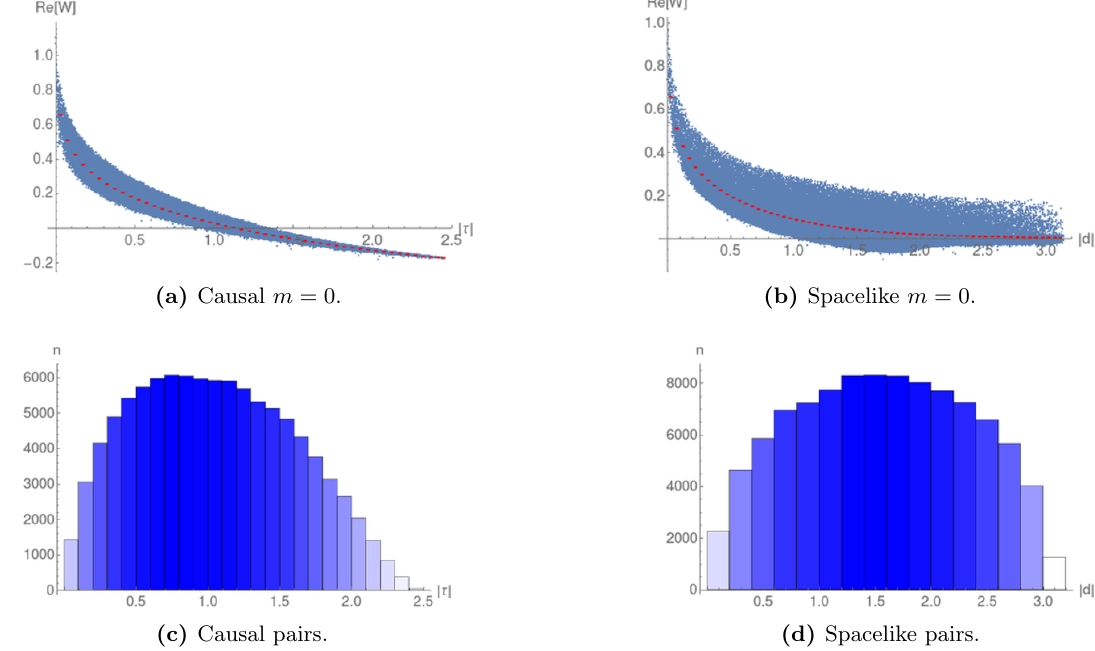
Figure 11. N = 32000 ; T = 1 ; (cid:26) = 1635 : 08, in 2d de Sitter. (a)-(b) represent Re[ W distance for a sample of 100000 randomly selected pairs, and the red curve represents the mean values with the SEM. (c)-(d) are plots of the distribution of pairs.